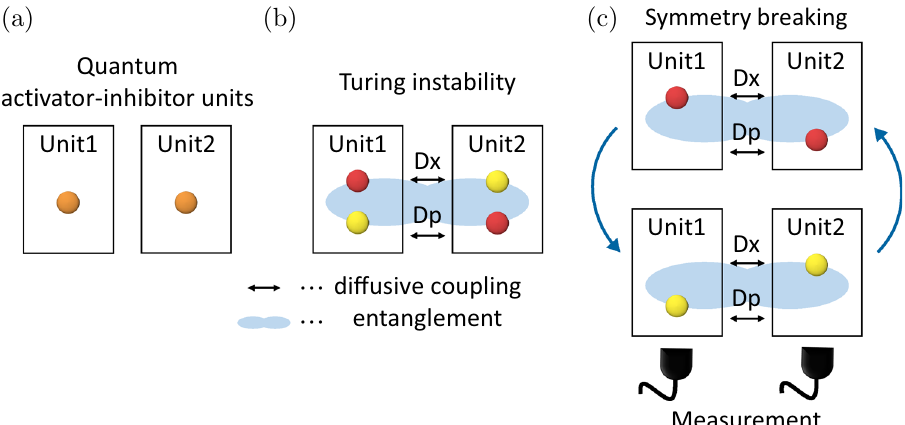
Figure 1. Quantum Turing instability. ( a ) Pair of quantum activator–inhibitor units. ( b ) Diffusive coupling between the two units can induce Turing instability, which leads to nonuniformity and entanglement between the units and yields a pair of nonuniform states that are symmetrically mixed due to quantum noise. ( c ) Further performing continuous measurement on the two units can break the symmetry and reveal the asymmetry caused by the Turing